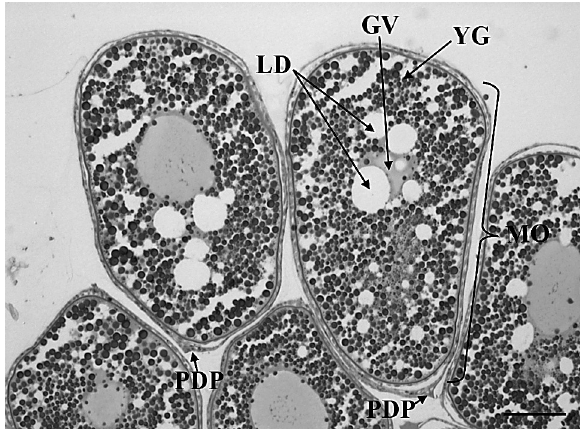
Fig . 6. – Early maturation stage oocyte exhibiting germinal vesicle migration, yolk granules, and lipid droplet coalescence (scale bar = 100 µm) GV = germinal vesicle, LD = lipid droplets, MO = matura- tion oocytes, PDP = peduncle detachment (ovulation) point, YG = yolk